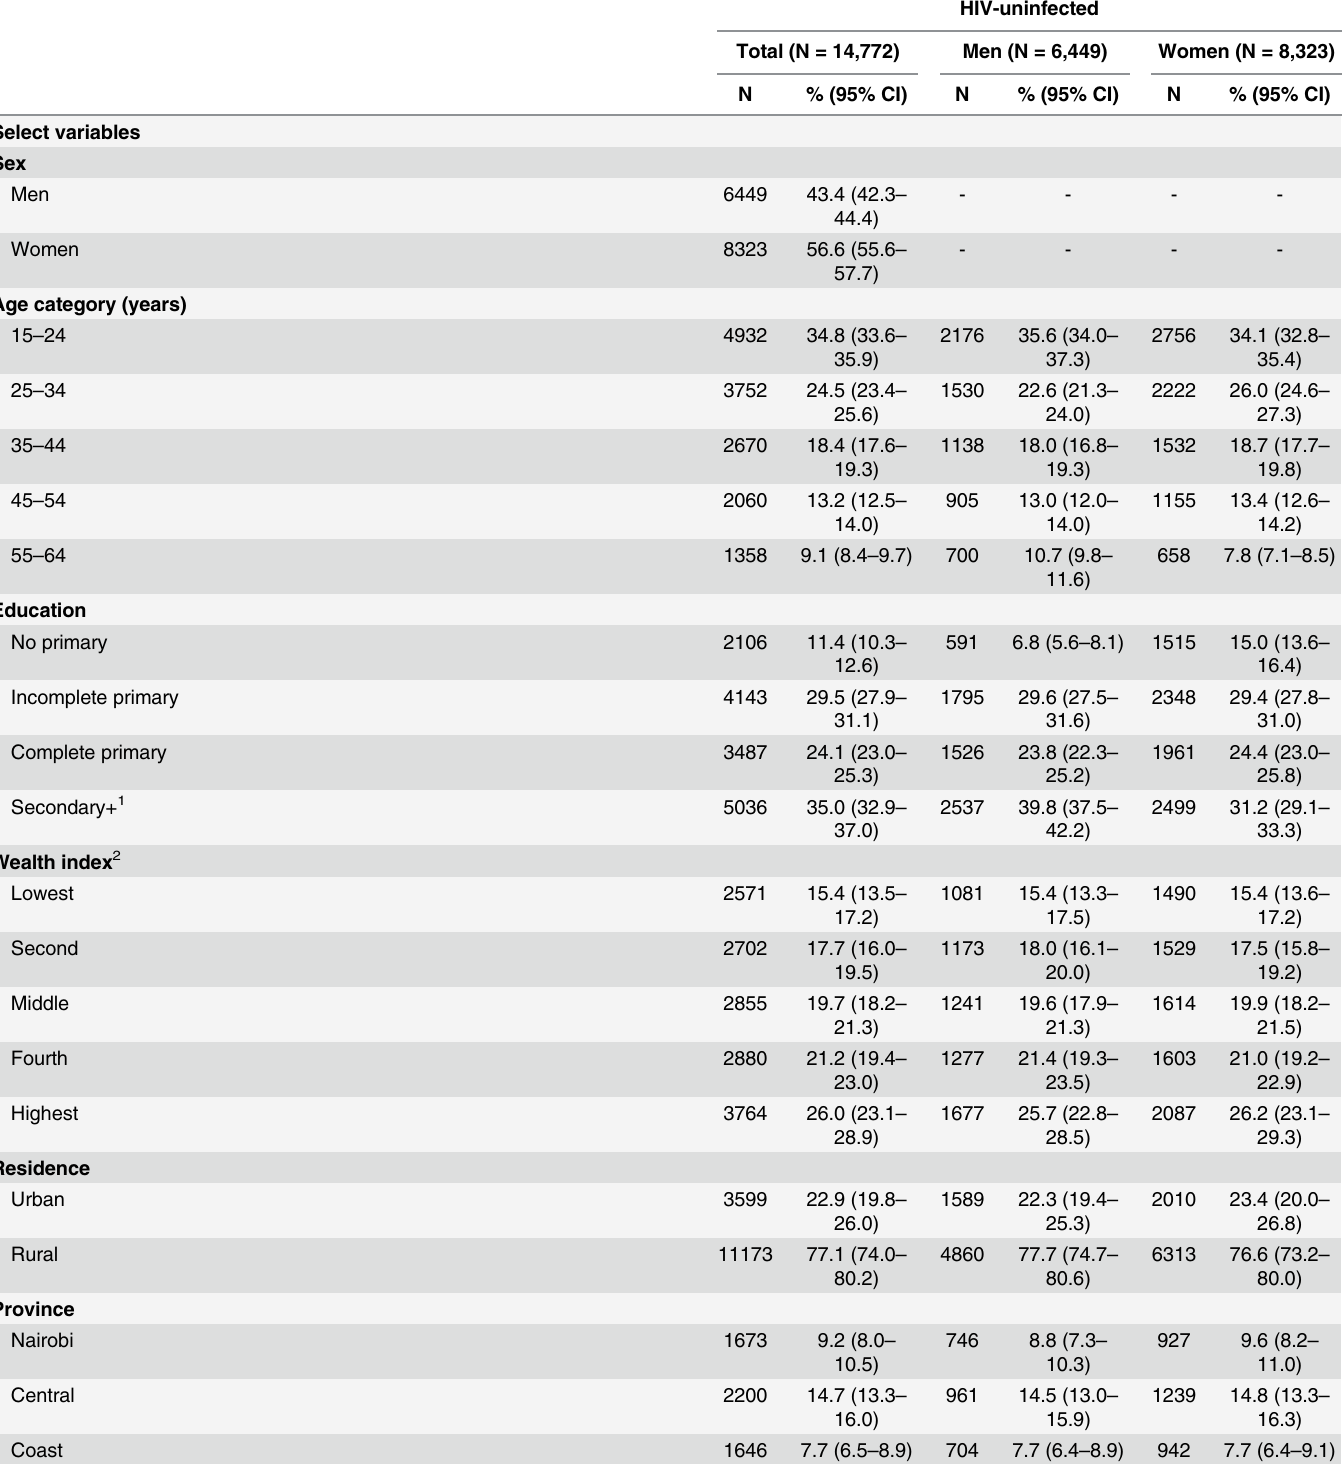
Table 2. Frequencies and weighted proportions of select demographic, behavioral, and biologic variables among HIV-uninfected women and men aged 15 – 64 years, 2007 Kenya AIDS Indicator